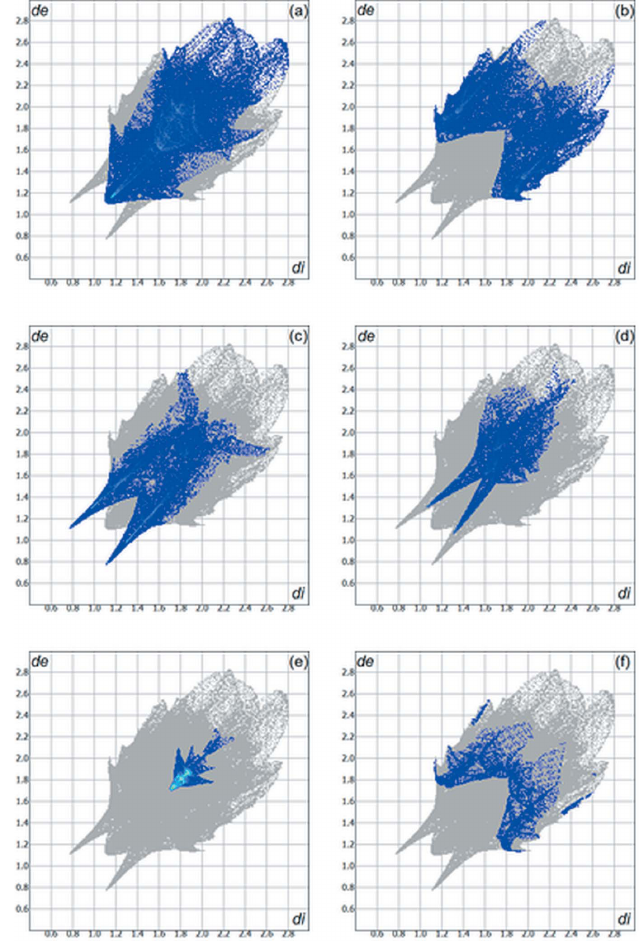
Figure 6 Hirshfeld surface two-dimensional fingerprint plot for the title compound showing ( a ) H (cid:2)(cid:2)(cid:2) H, ( b ) H (cid:2)(cid:2)(cid:2) C, ( c ) O (cid:2)(cid:2)(cid:2) H and ( d ) H (cid:2)(cid:2)(cid:2) F, ( e ) C (cid:2)(cid:2)(cid:2) C and ( f ) H (cid:2)(cid:2)(cid:2) N contacts in detail (cyan dots). The contribution of the interactions to the crystal packing amounts to 31.80, 24.30, 15.20, 10.80, 06.20 and 04.30%, respectively. The d e ( y axis) and d i ( x axis) values are the closest external and internal distances (values in A˚ ) from given points on the Hirshfeld surface